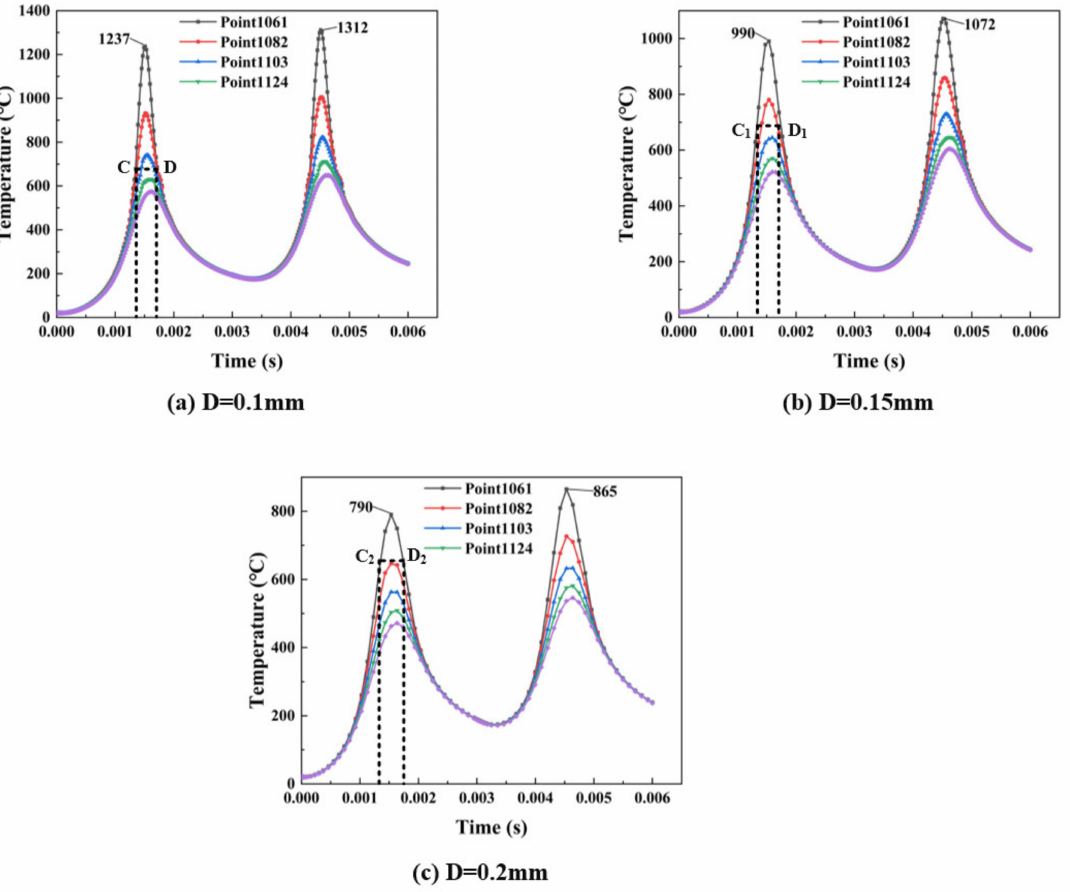
Figure 10. Temperature curve for different spot diameters with time changes ( a ) Temperature distribution when D = 0.1 mm ( b ) Temperature distribution when D = 0.15 mm ( c ) Temperature distribution when D = 0.2